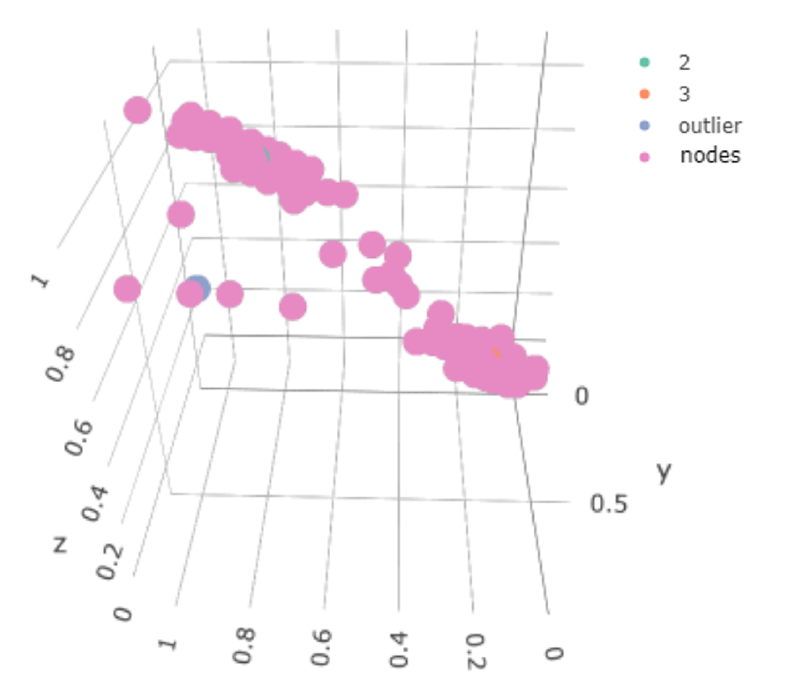
Figure 14. Status of the weights associated with the map generated for the second